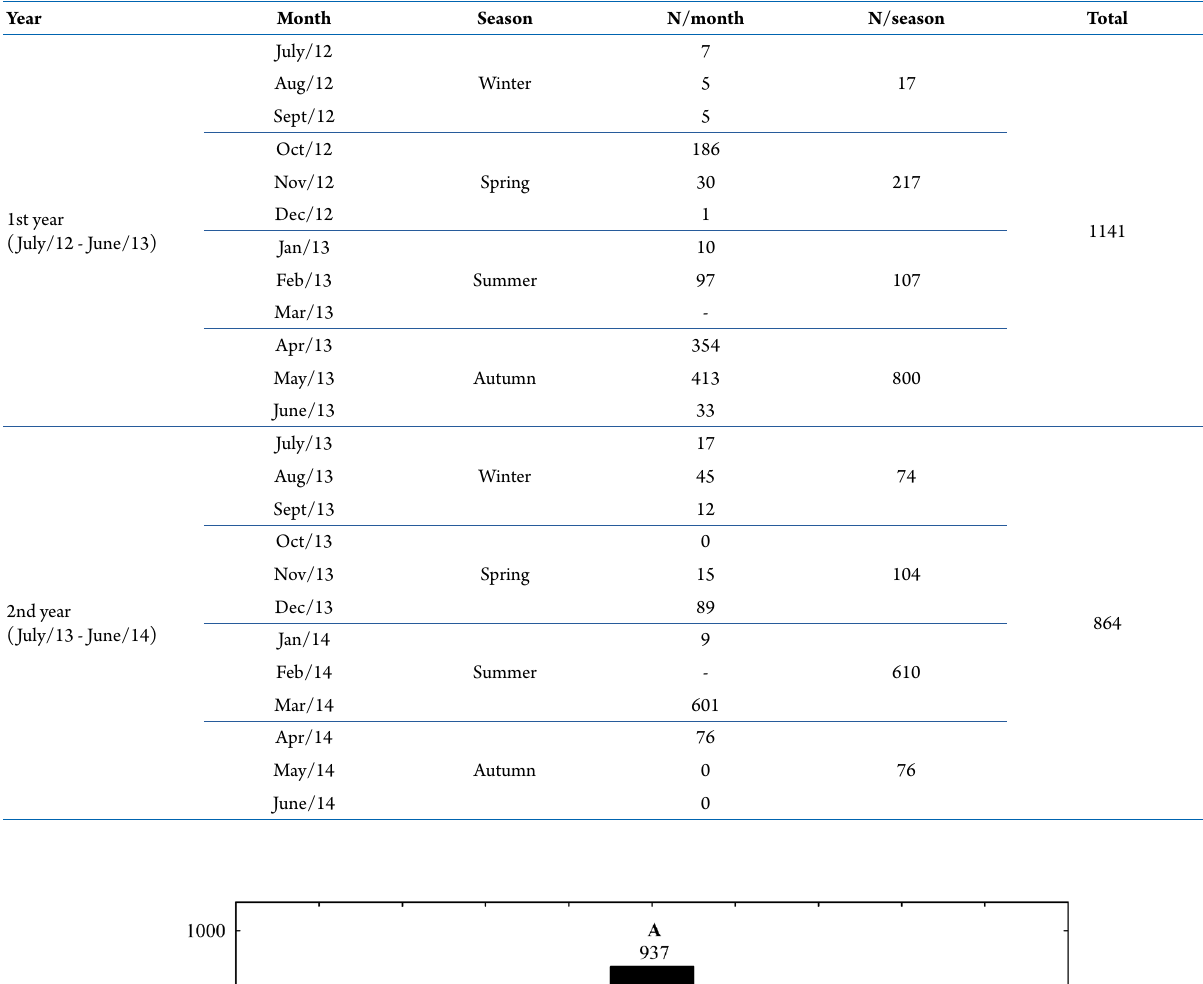
Table 1. Abundance of Exhippolysmata oplophoroides in each month and each season, from July/2012 to June/2014, in Cananéia, Brazil. The sign (-) indicates months when there was no sampling due to bad weather conditions.